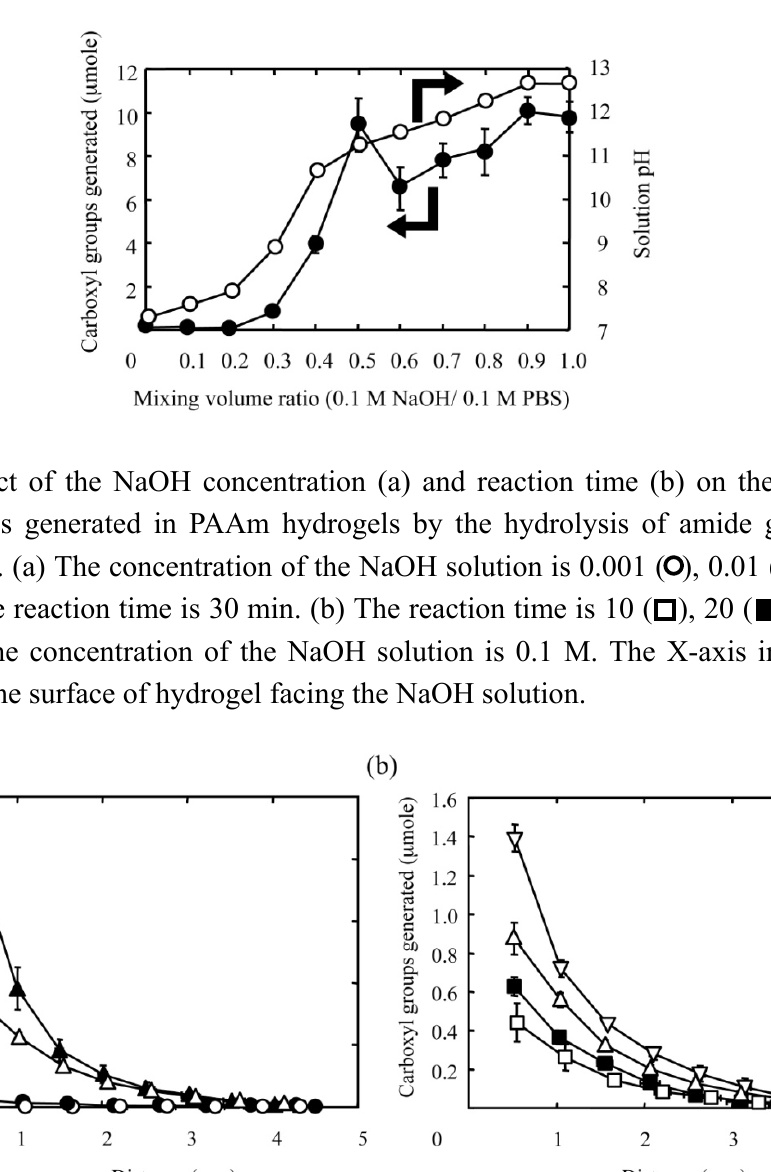
Figure 2. Generation of carboxyl groups in PAAm hydrogels in different concentrations of NaOH solution: ( ) the amount of carboxyl groups generated in PAAm hydrogels and ( ) the pH value of solutions at different concentrations of NaOH.